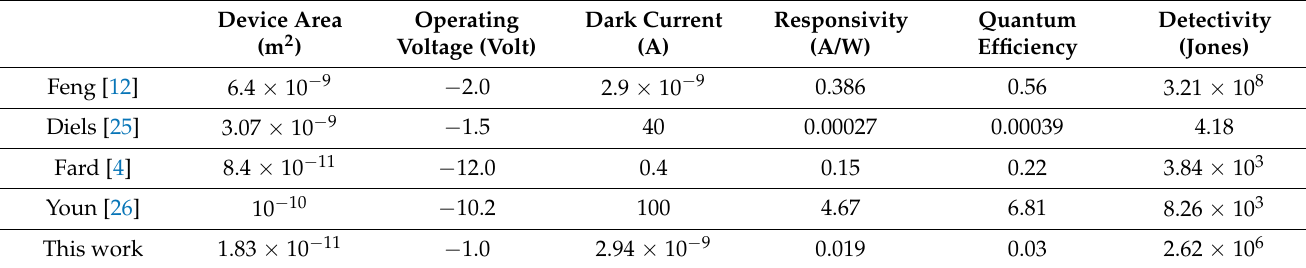
Table 1. 850 nm photodetectors’ performance